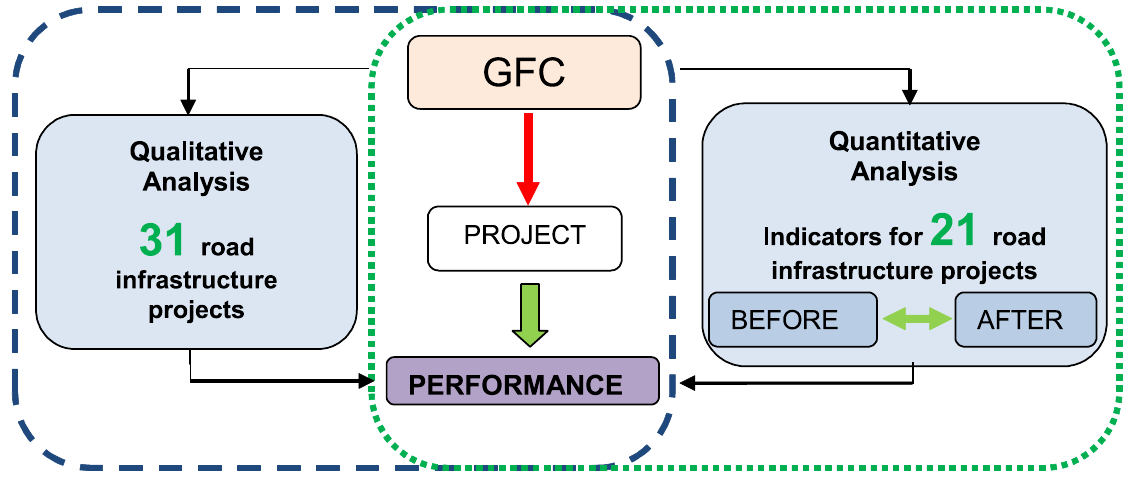
Figure 1. Methodology scheme (Source: Authors’